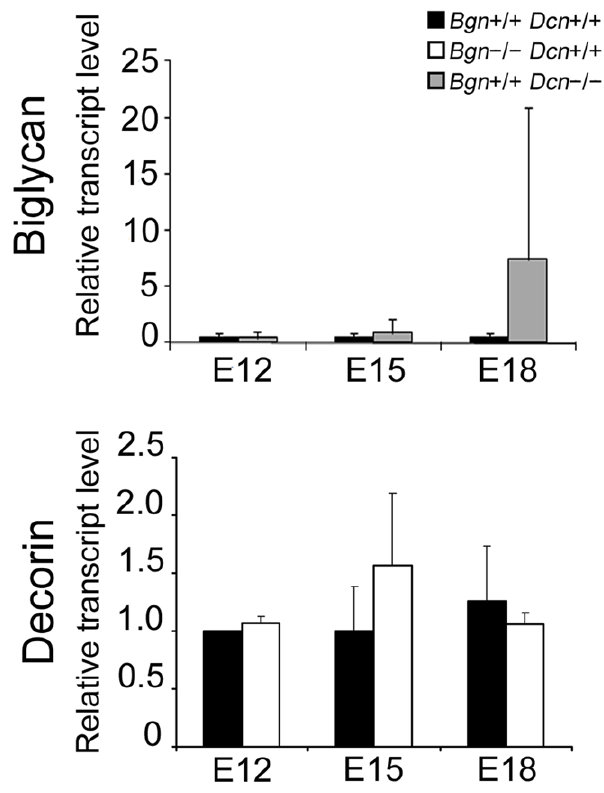
Figure 5. Lack of a significant compensatory mechanism at the gene level between biglycan and decorin in the knockout mice. Levels of biglycan mRNA in wild-type and Bgn + / + Dcn 2 / 2 mouse uterus, as well as decorin mRNA in wild-type and Bgn 2 / 2 Dcn + / + mouse uterus were determined using qPCR at progressive gestational ages. Biglycan and decorin are not developmentally regulated in the pregnant uterus, nor do they compensate for each other at the transcript level in the Bgn 2 / 2 Dcn + / + or the Bgn + / + Dcn 2 / 2 ( P =0.271 and P =0.351 respectively). Two-way ANOVA Holm-Sidak. n=4 2 6 samples from 4–6 pregnant dams per condition. E=embryonic day. Error bars=SD.